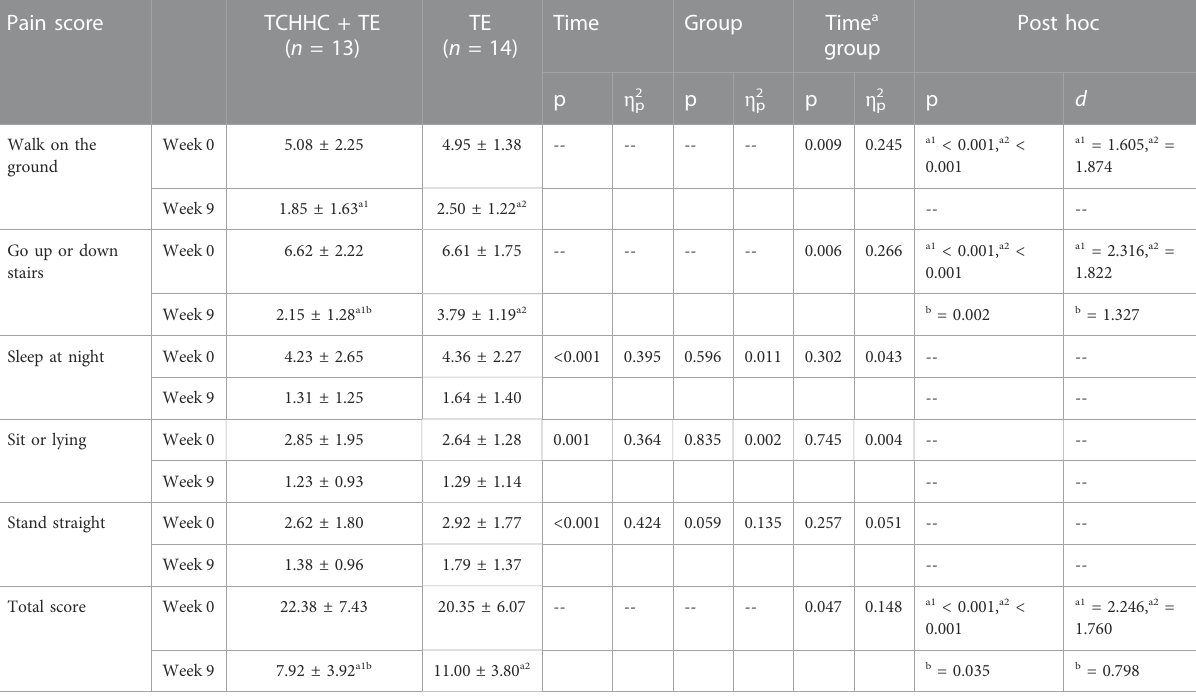
TABLE 3 Pain score of the more affected at weeks 0 and